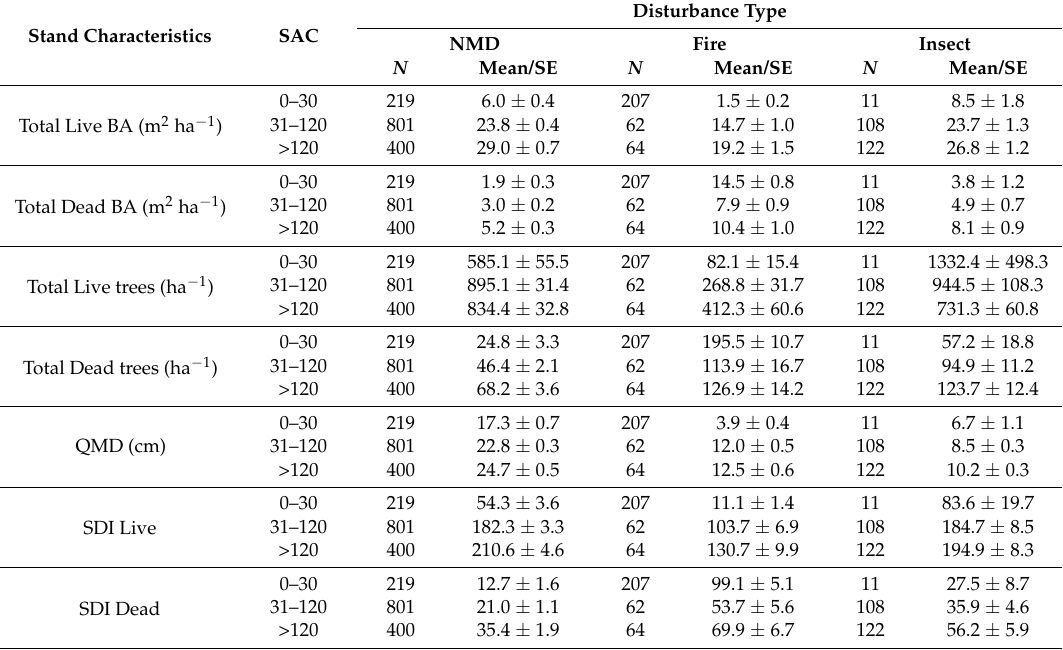
Table 2. Mean and standard error of stand characteristics for each disturbance type and development stage. Total live and total dead refer to the cumulative amount of interior Douglas-fir and other species within the stand composition for each stand characteristic in the